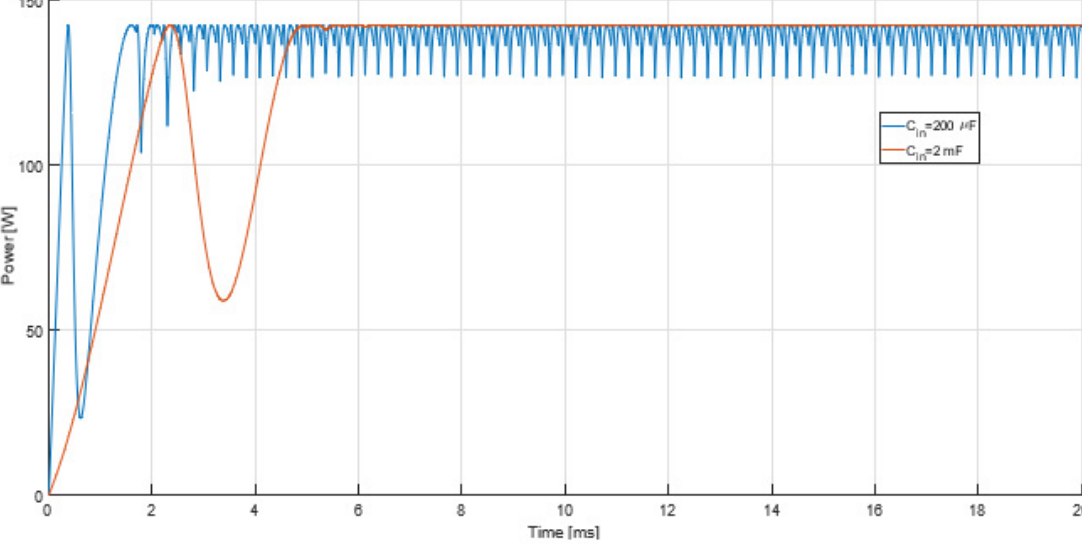
Figure 33. Solar array output power for 2 different decoupling capacitance values (zoomed in).